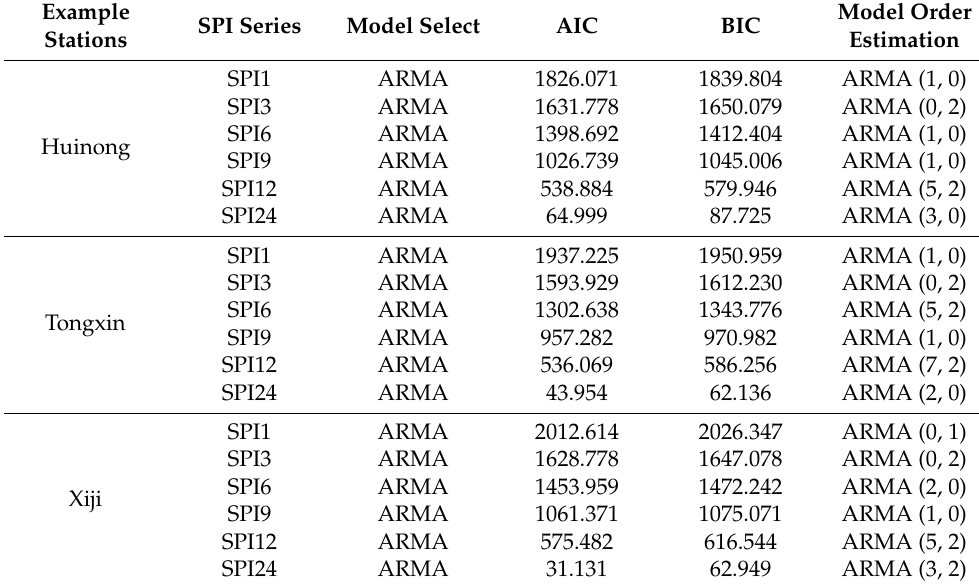
Table 4. Model order based on SPI values of six time